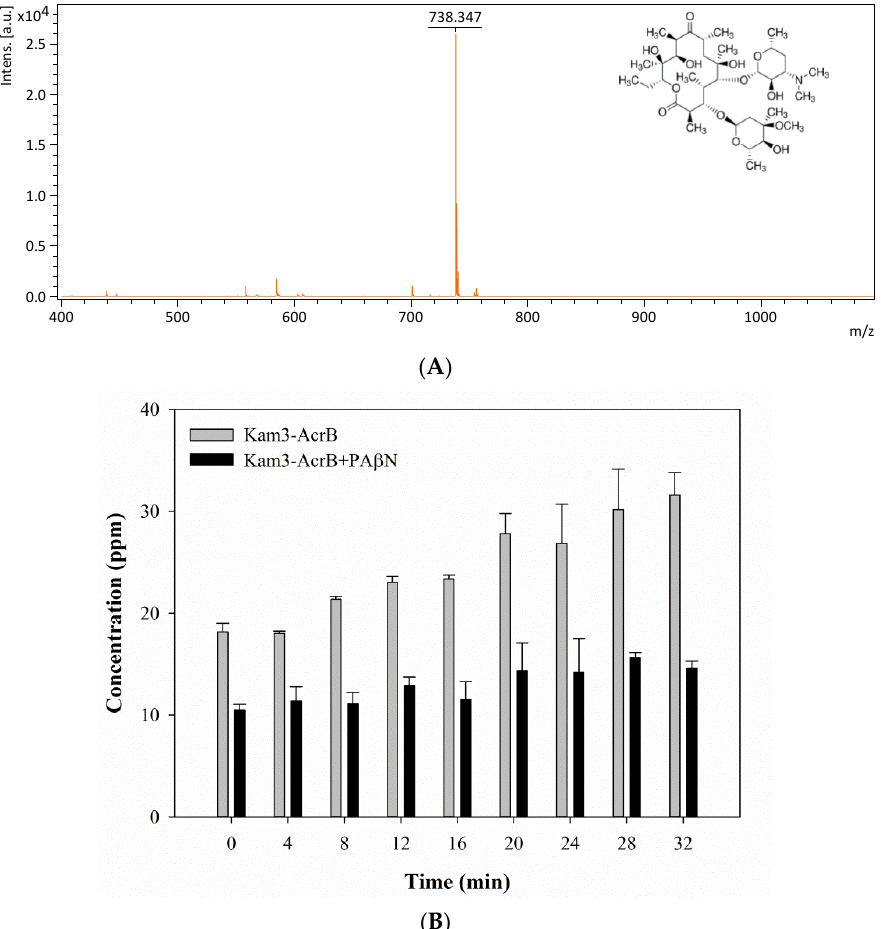
Figure 7. The erythromycin efflux activity of Kam3-AcrB was detected by using MALDI-TOF MS in the presence of modulator PAβN . ( A ) The mass spectrum of erythromycin and ( B ) the intensity of extracellular erythromycin. The intensity was plotted at the main peak at m / z 738.35 of erythromycin and the detection period was 32 min. Values are expressed as mean ± standard deviation (SD) ( n = 3).